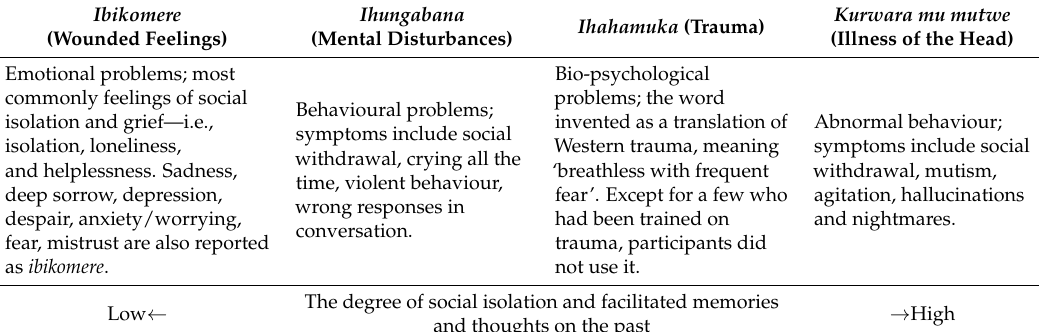
Table 3. Locally perceived development of mental health impact of